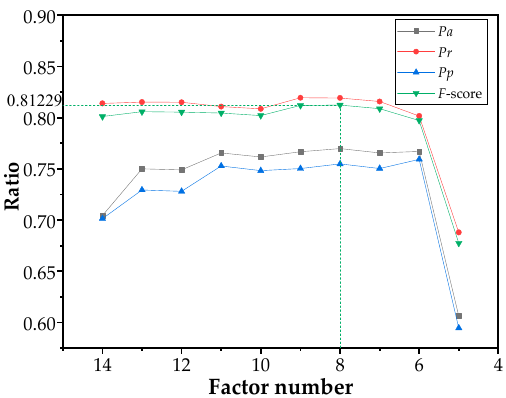
Figure 4. Variation of assessment indexes with wildfire-related factors.